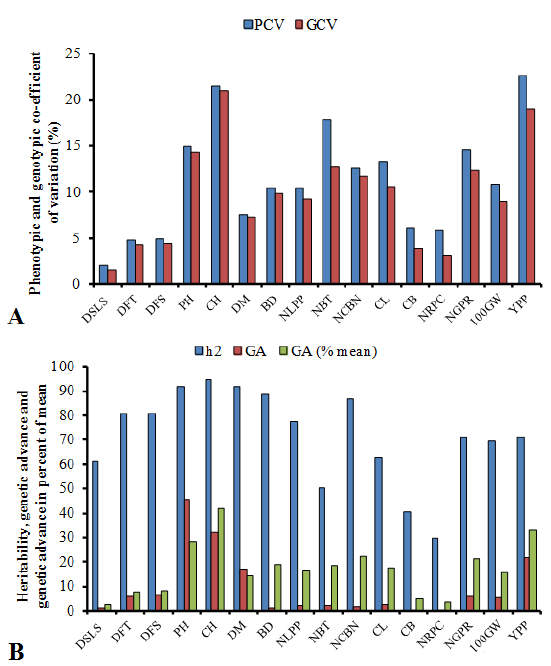
Fig. 2. Estimation of genetic parameters for different characters in white maize: A) phenotypic (PCV) and genotypic (GCV) co-efficient of variation; B) heritability (h2), genetic advance (GA), and genetic advance in percent of the mean